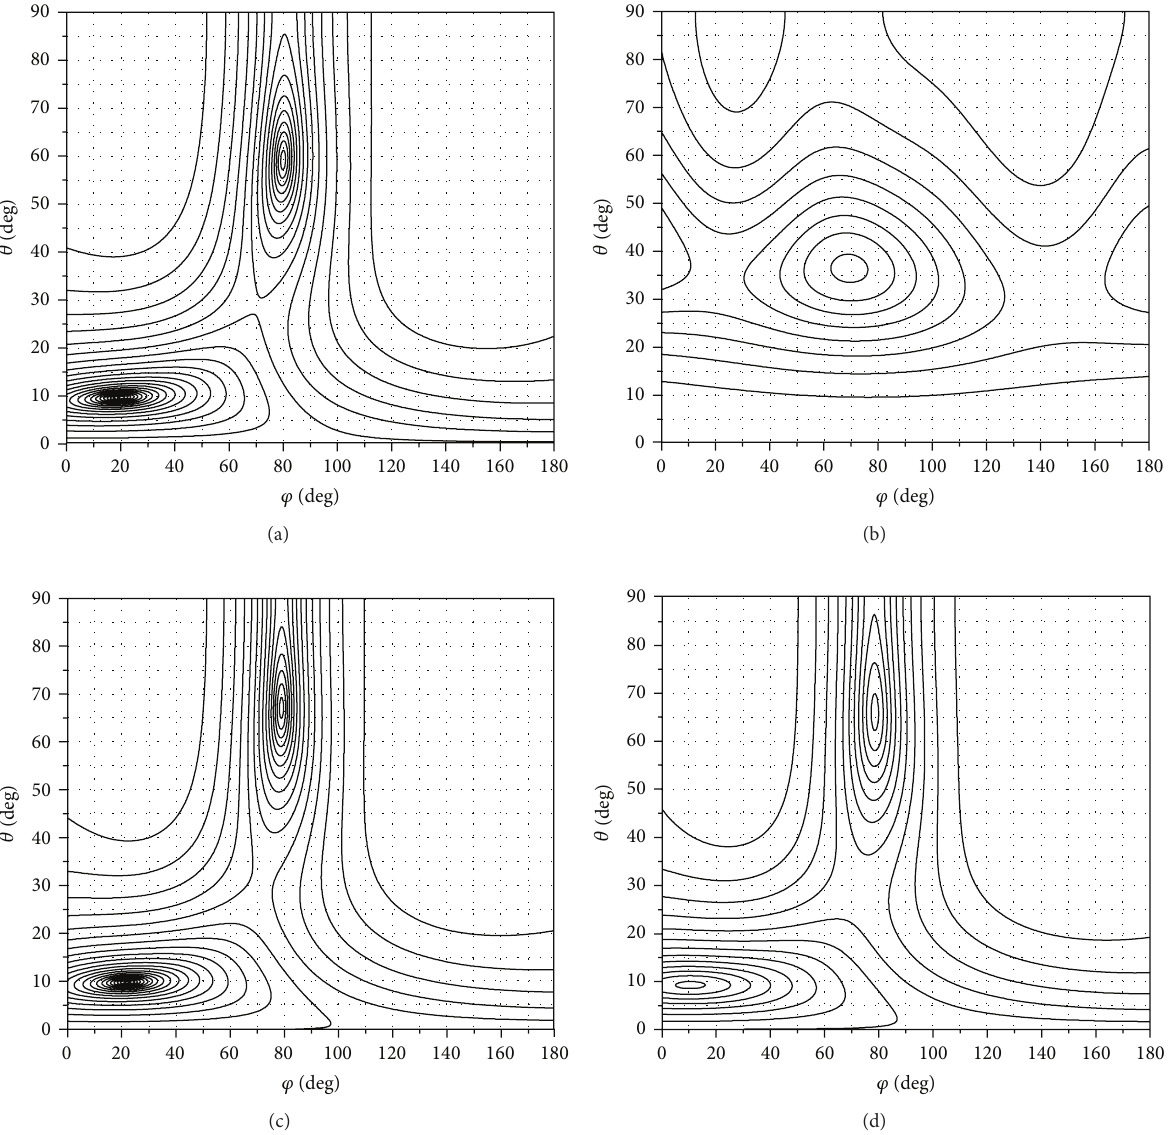
Figure 10: Contour charts of the 2D DOA estimations for (a) the proposed method, (b) Su’s method, (c) the open-circuit voltage method, and (d) without